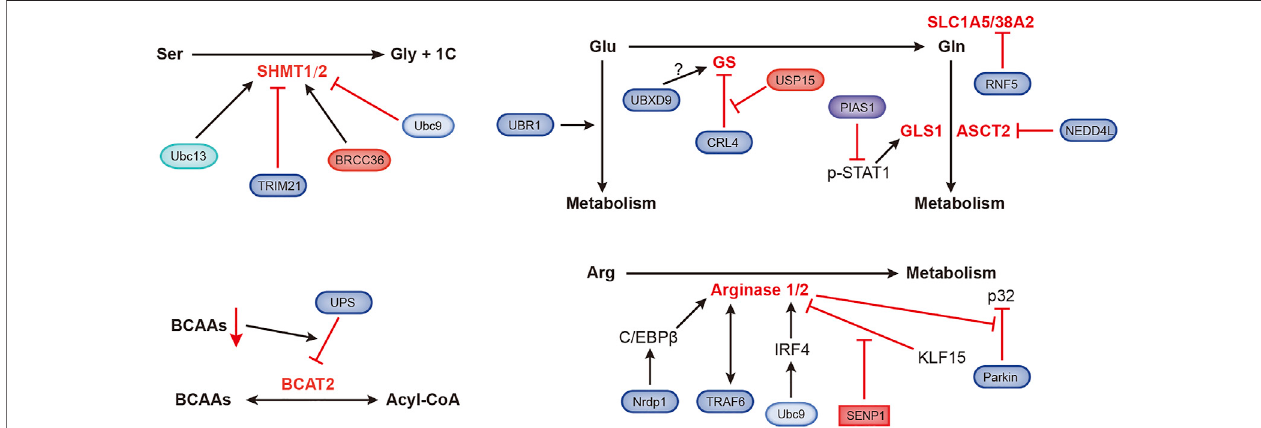
FIGURE 5 | Ubiquitination- and SUMOylation-mediated regulation of amino acid metabolism. The black and red arrows represent activation and inhibition, respectively. ASCT2, alanine, serine, cysteine-preferring transporter 2; BCAAs, branched-chain amino acids; BCAT2, branched-chain amino acid transaminase 2; BRCC36, Zn 2+ -dependent deubiquitinating enzyme; CRL4, Cullin-RING ubiquitin ligase 4; GLS1, glutaminase 1; GS, glutamine synthetase; IRF4, interferon regulatory factor 4; KLF15, Kruppel-like factor 15; NEDD4L,NEDD4-like E3ubiquitin protein ligase; Nrdp1, ring fi nger protein 41; PIAS1, protein inhibitor of activated STAT1; RNF5, ring fi nger protein 5; SHMT1/2, serine hydroxymethyltransferase 1/2; SLC1A5/38A2, L-glutamine carrier proteins; Ubc9, ubiquitin-conjugating enzyme; Ubc13, SUMO E2-conjugating enzyme; UBR1, ubiquitin protein ligase E3 component n-recognin 1; UBXD9, UBX domain containing 9; USP15, ubiquitin-speci fi c protease